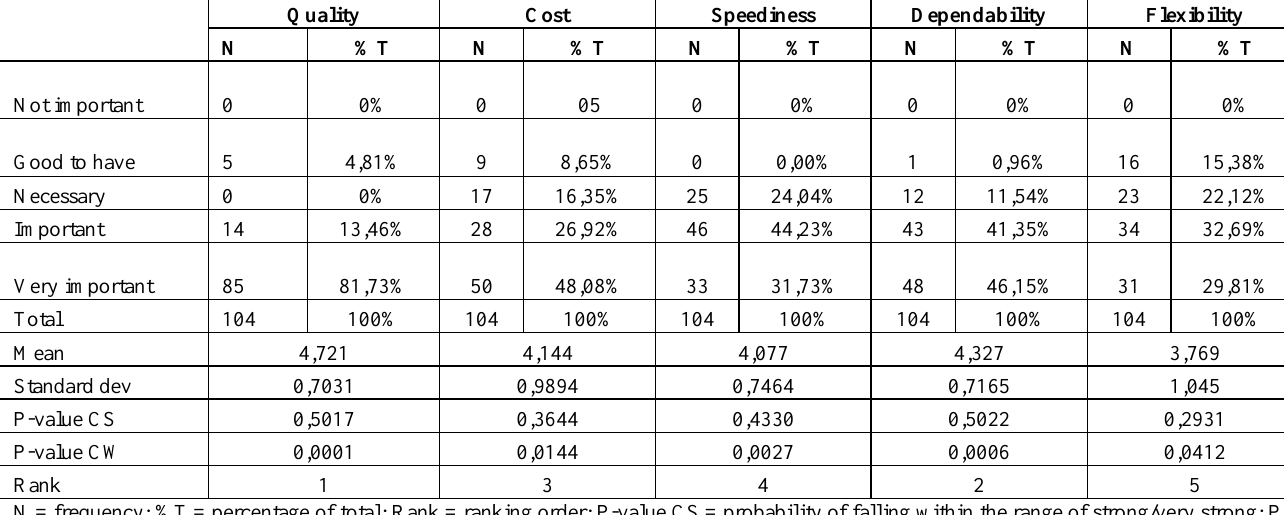
Table 6: Future importance of competitive operations priorities to compete better nationally Quality Cost